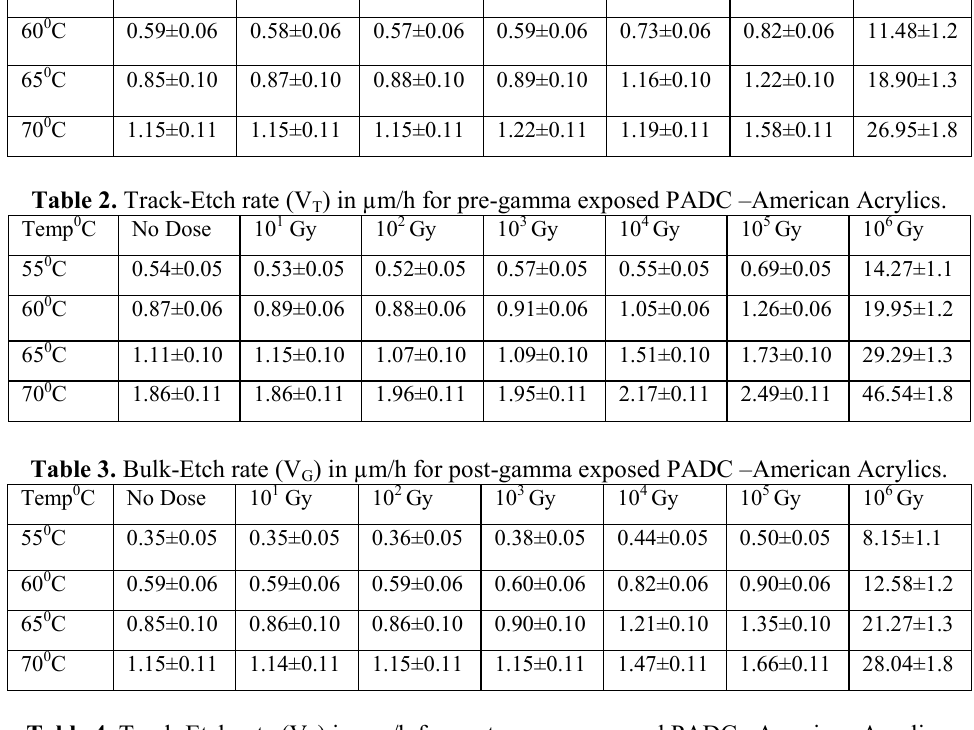
Table 4. Track-Etch rate (V Temp 0